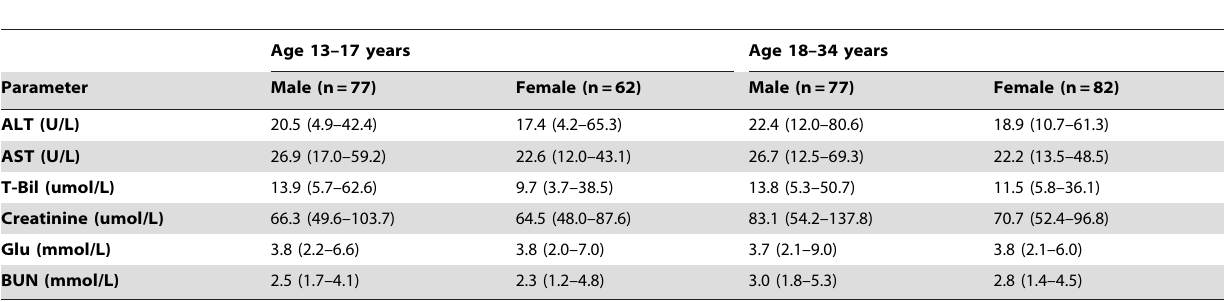
Table 6. Clinical Chemistries Medians and 95% Reference Intervals stratified by age and gender from a 13–34 years cohort study in rural western Kenya